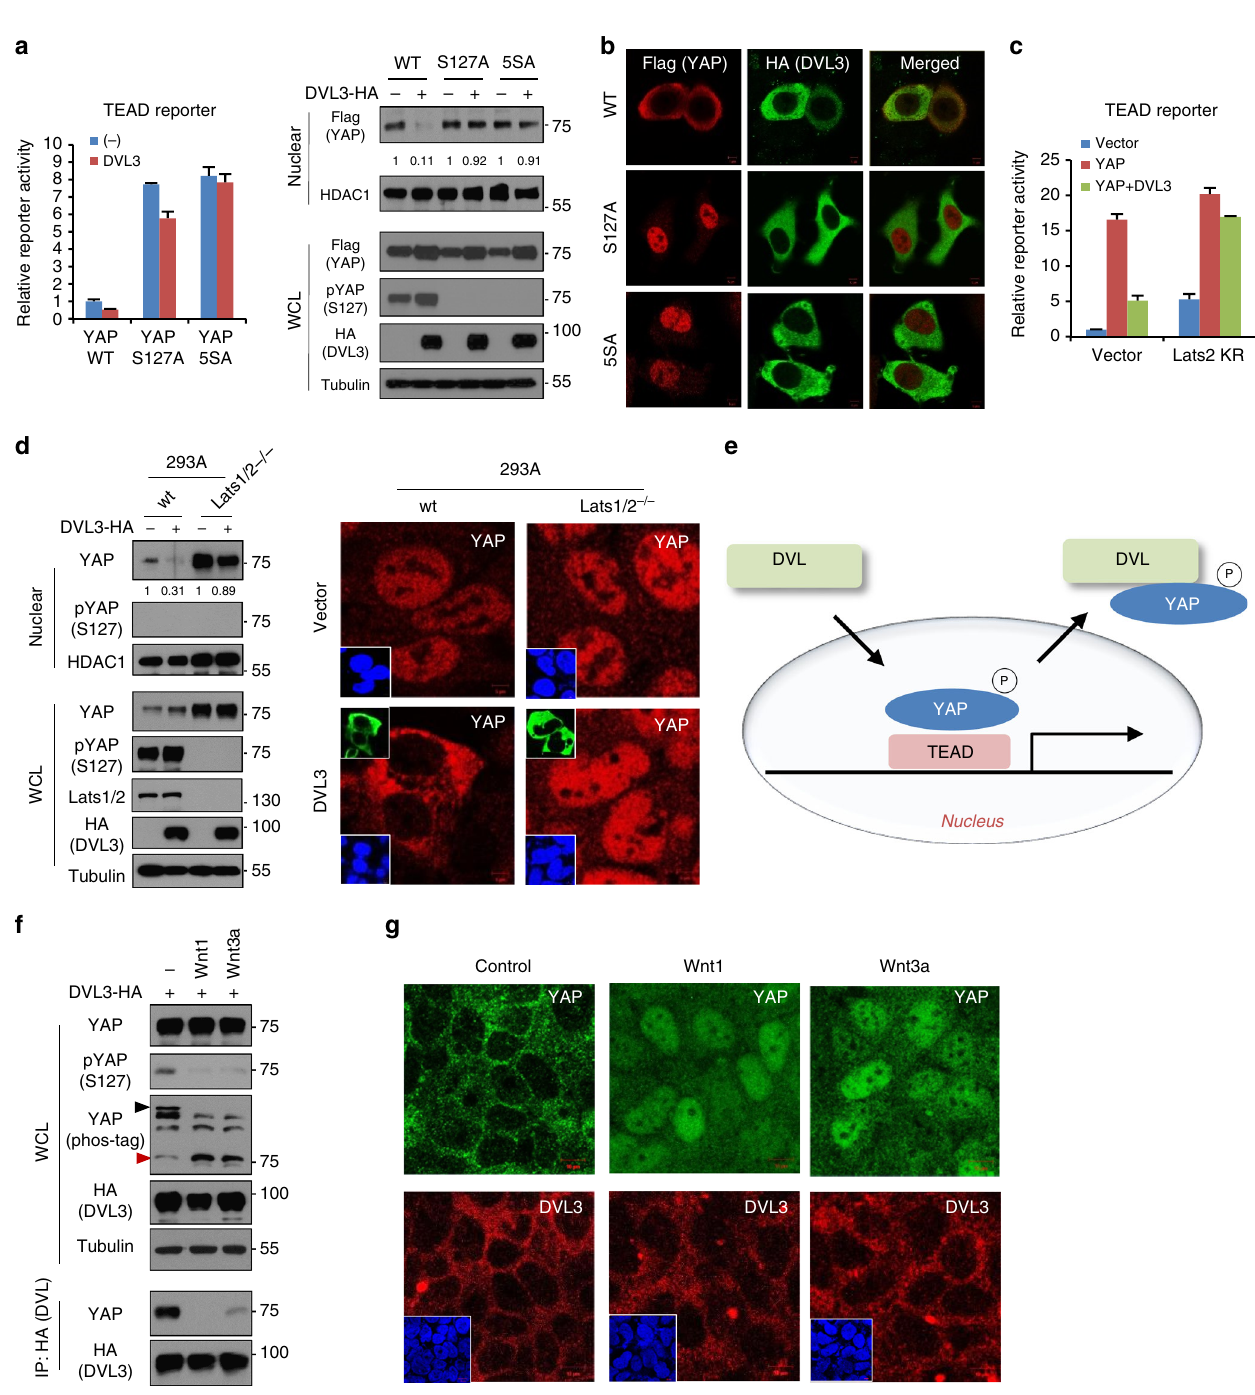
Fig. 4 DVL has nuclear export function on phosphorylated YAP. a Relative fold repression of reporter activities and nuclear YAP abundance by DVL on wt or phospho-resistant mutants of YAP (S127A, 5SA) were measured with TEAD reporter assay (left panel) and immunoblot analysis (right panels), respectively. Relative nuclear YAP abundance compared to control was measured by ImageJ. b The MCF-7 cells were transfected with HA-tagged DVL3 in combination with fl ag-tagged wt or phospho-resistant mutants YAP (S127A, 5SA), and nuclear localizations of YAP and DVL were examined by confocal immuno fl uorescence microscopy. To minimize the overexpression issue, 10 ng of YAP expression vectors was used. Scale bar, 10 μ m. c YAP and DVL3 were co-transfected in combination with vector control or dominant negative Lats2 (Lats2-KR), and relative TEAD reporter activity was measured. Data presented as mean ± SD, n = 3. d DVL3 was transfected in wt or Lats1/2 double-knockout (Lats1/2 − / − ) 293A cells, and nuclear YAP abundance by DVL3 was determined by immunoblot analysis (left panels) and immuno fl uorescence study (right panels). The cells were serum-starved for 16 h before harvest. e Schematic diagram of nuclear export of phosphorylated YAP by DVL. f Wnt ligands activate YAP resulting in decreased interaction with DVL. The 293A cells transfected with HA-tagged DVL3 were serum-starved and then stimulated by Wnt1 and Wnt3a ligands for 4 h. The whole-cell lysates (WCL) were subjected for immunoblot analysis and immunoprecipitation (IP) assay with anti-HA antibody. g Soluble Wnt1 and Wnt3a induce YAP nuclear localization. The con fl uent 293A cells were serum-starved and then stimulated by Wnt ligands for 4 h. Endogenous YAP and DVL localization were determined by confocal immuno fl uorescence microscopy. Scale bar, 10 μ m. Unprocessed original scans of blots are shown in Supplementary Fig.